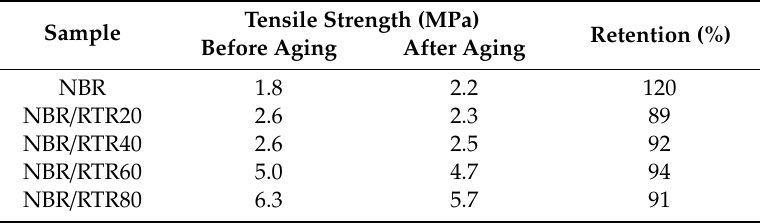
Table 5. Tensile strength of NBR / RTR compounds before and after aging (reproduced with permission from [116]).